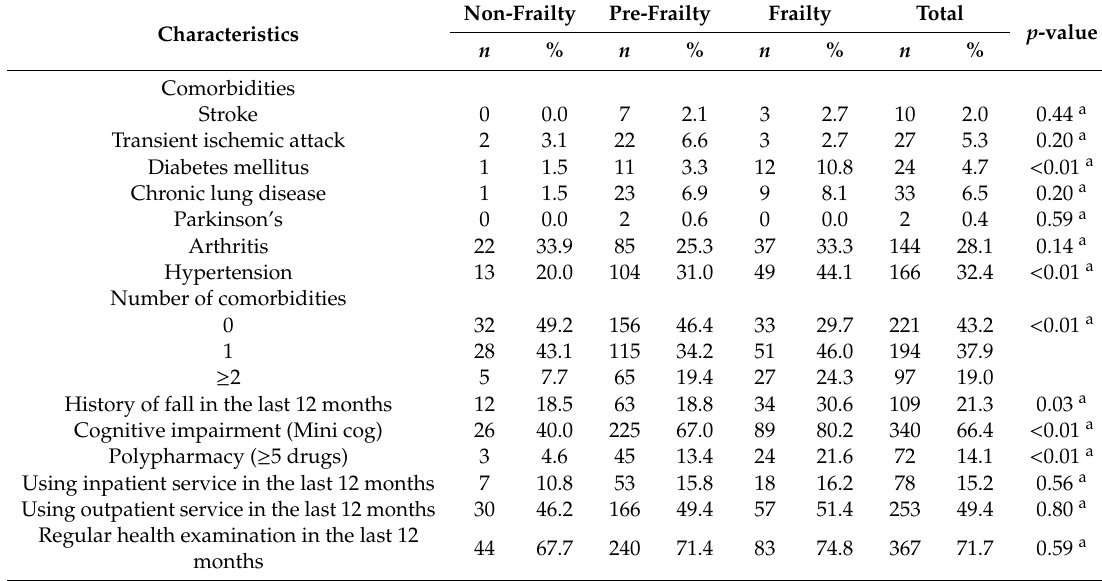
Table 2. Health status and health service utilization according to frailty status. Characteristics